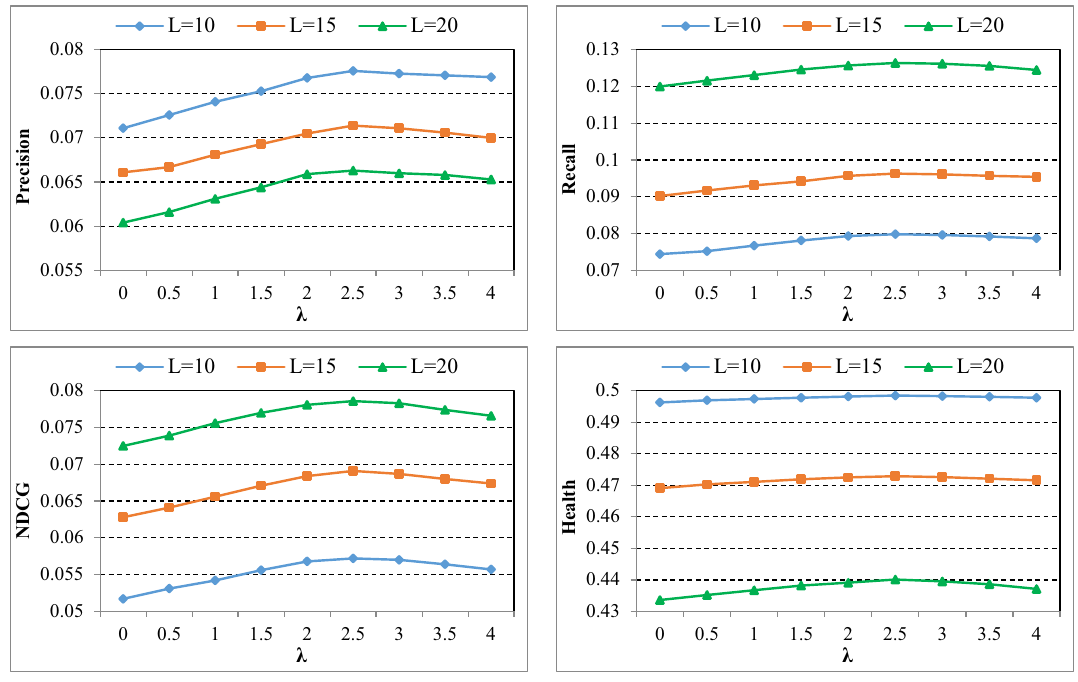
Fig. 2 Experimental results regarding the sensitivity analysis of the parameter 𝜆